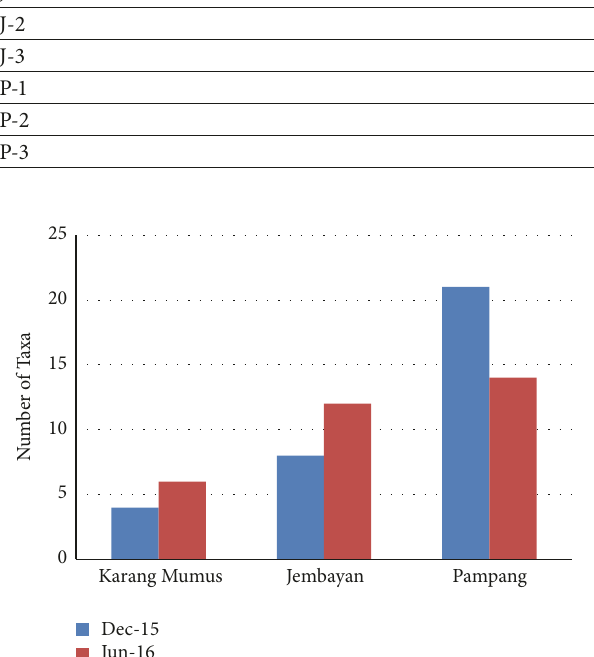
Figure 4: Taxa Richness of benthic macroinvertebrate.